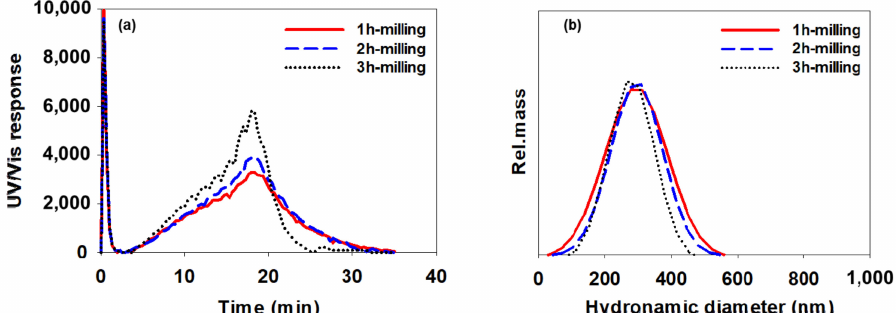
Figure 10. AsFlFFF fractograms ( a ) and size distributions ( b ) of the CB dispersions prepared with SMA-1000. The channel and the cross-flow rate were 0.8 and 0.3 mL/min, respectively. The carrier liquid was water containing 0.1% FL-70 and 0.02% NaN 3 .